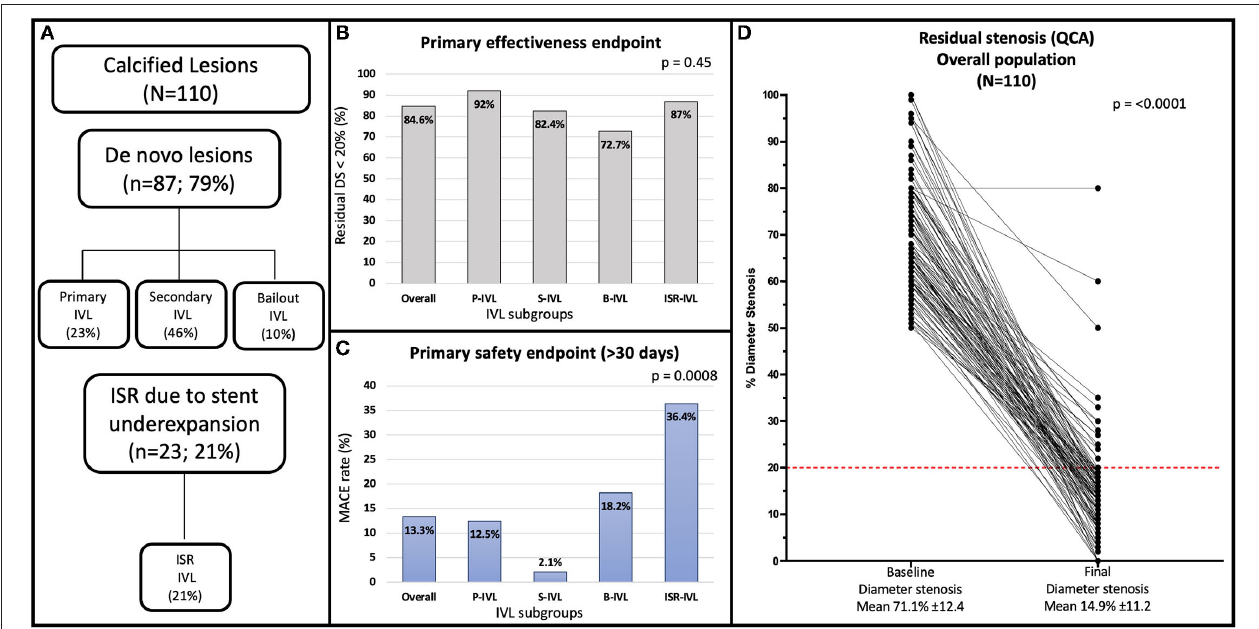
FIGURE 1 | (A) Flowchart of the study. (B) Angiographic success rate in the overall population and treatment subgroups. (C) Late (median 12.9 months) MACE rate in the overall population and treatment subgroups. (D) Quantitative coronary angiography showing percent diameter stenosis at baseline and after the procedure for the overall population. The red line indicates the < 20% residual stenosis threshold after procedure included in the primary effectiveness endpoint of the study. B-IVL, bailout intravascular lithotripsy; ISR, in-stent restenosis; ISR-IVL, intravascular lithotripsy for in-stent restenosis; IVL, intravascular lithotripsy; MACE, major adverse cardiovascular event; P-IVL, primary intravascular lithotripsy; QCA, quantitative coronary angiography; S-IVL, secondary intravascular